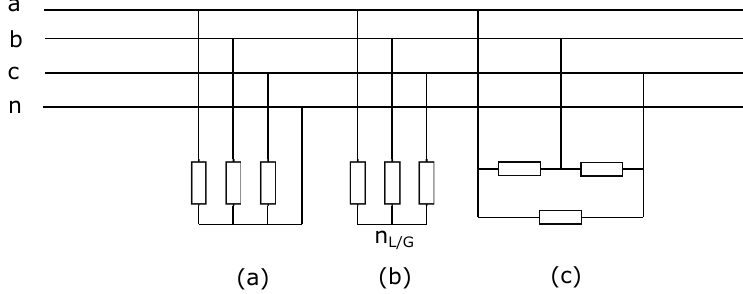
Figure 6. Example of three-phase wye (a and b) and delta (c) loads/renewable generators at bus i